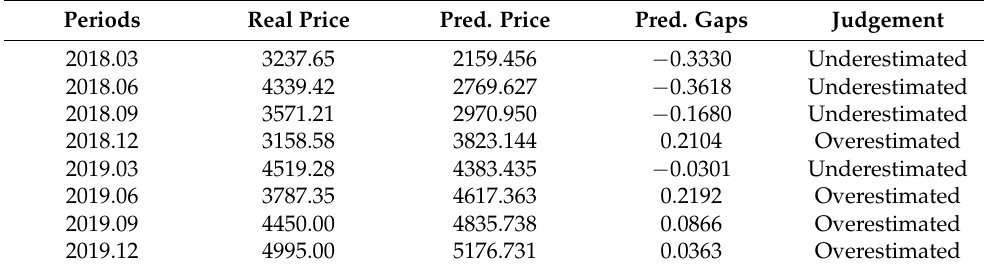
Table 6. BPNN model for the results of prediction and